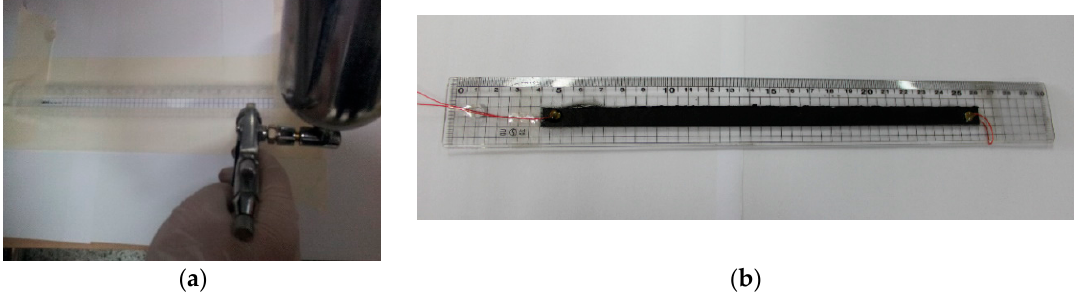
Figure 1. Fabrication of the multi-walled carbon nanotube (MWCNT)/epoxy neuron with spray: ( a ) spray on a patterned bar; ( b ) fabricated neuron on a plastic ruler (3 wt. % MWCNT, 220 mm × 10 mm × 0.33 mm, R = 3.07 k Ω ).